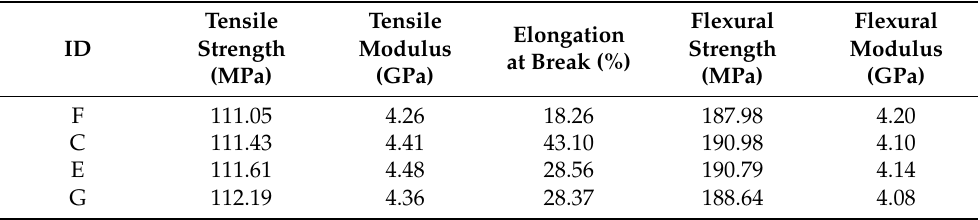
Table 4. Tensile and bending properties with different hot compression